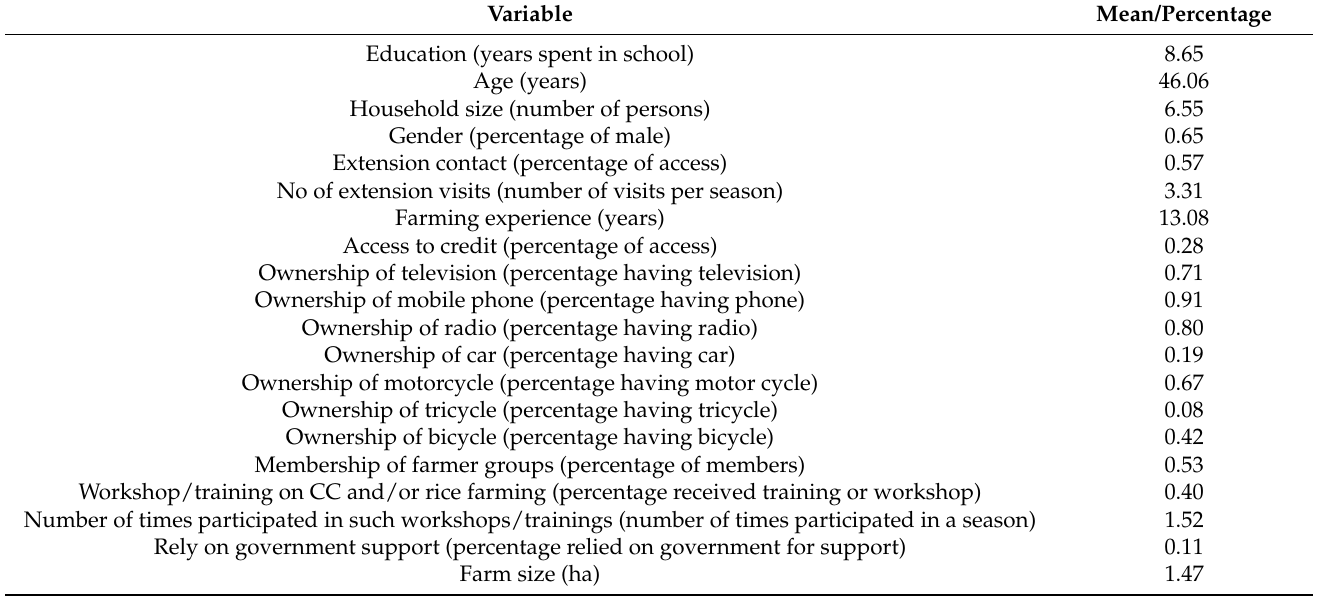
Table 1. Socio-economic characteristics of